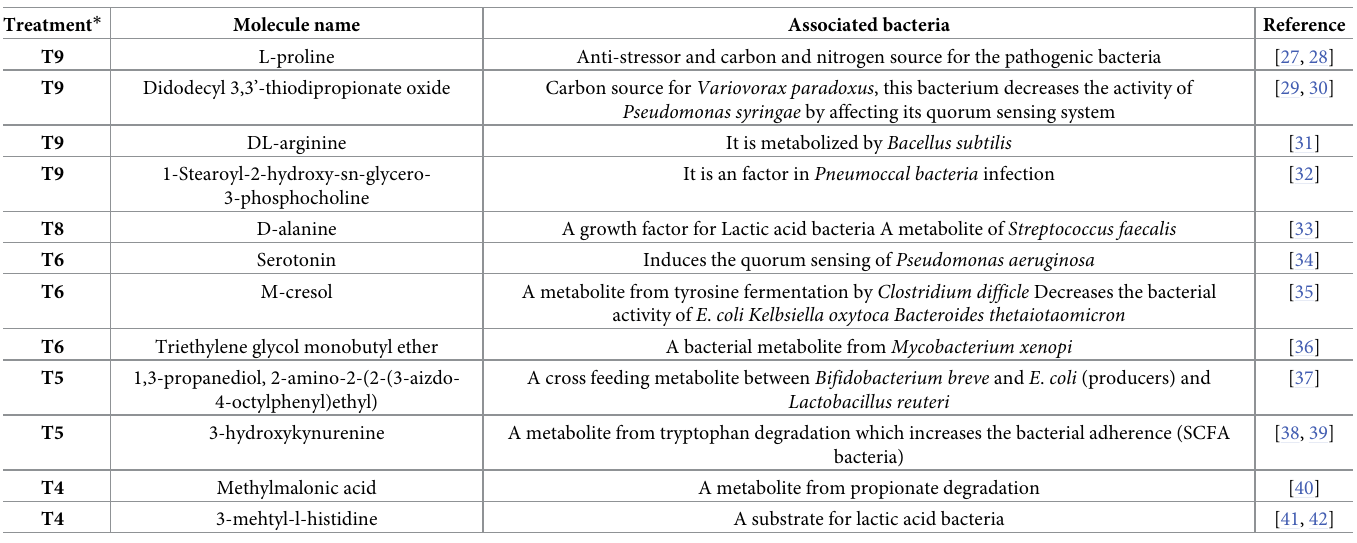
Table 1. Biofloc derived molecules as bacterial activity